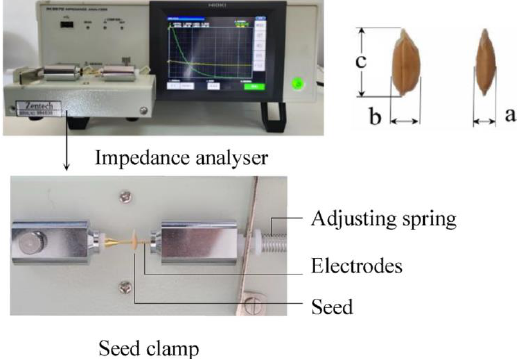
Figure 4. Rice seed impedance spectroscopy measurement experimental platform (longitudinal length c, maximum cross-sectional minor xis a, and major axis b) (reprinted from Ref. [1]).